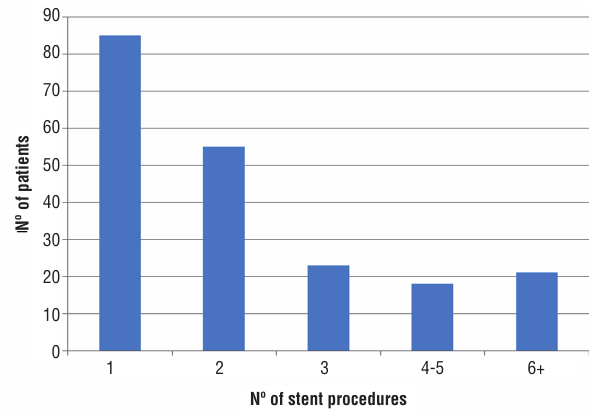
Figure 1 - Number of stent procedures (initial and subsequent) performed in women with cervical cancer.